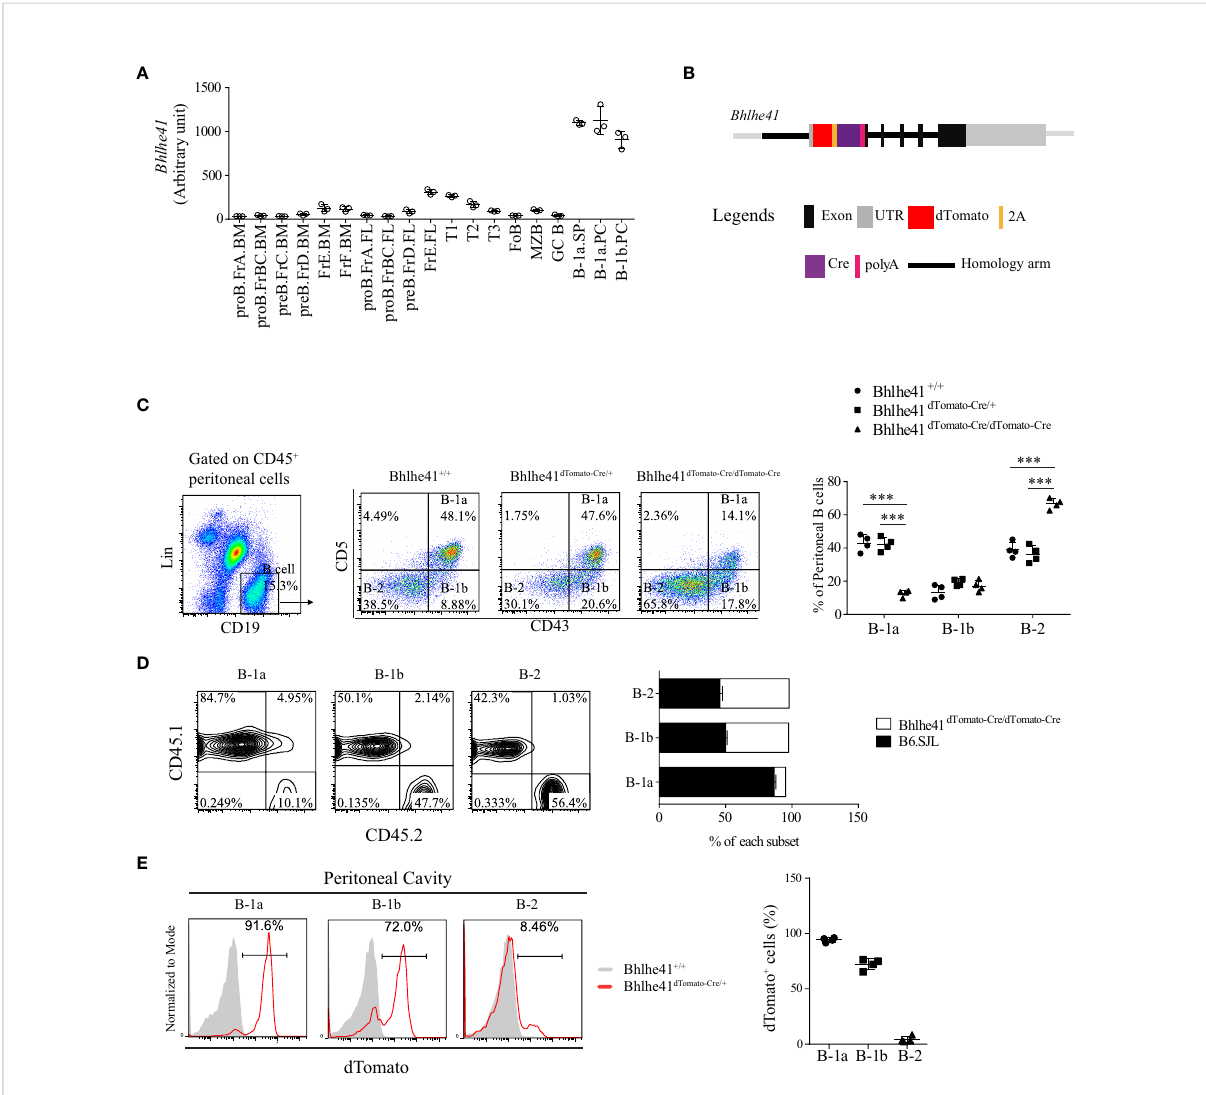
FIGURE 1 Generation of Bhlhe41 reporter and knockout mouse model Bhlhe41 dTomato-Cre . (A) Analysis of Bhlhe41 expression in different stages of B cells using a public gene expression microarray data (GSE15907) after quantile normalization. (B) Targeting construct for the Bhlhe41 locus with a dTomato-2A-Cre-polyA cassette inserted upstream of the Atg start site of Bhlhe41 locus. (C) Flow cytometric analysis of peritoneal B cells from adult Bhlhe41 +/+ , Bhlhe41 dTomato-Cre/+ , and Bhlhe41 dTomato-Cre/dTomato-Cre mice. The gating strategy for each type is illustrated on the left panel. One-way ANOVA followed by Bonferroni multiple comparison test was used for the statistical analysis. (D) Flow cytometric analysis of dTomato expression in peritoneal B cells from adult Bhlhe41 +/+ , Bhlhe41 dTomato-Cre/+ , and Bhlhe41 dTomato-Cre/dTomato-Cre mice. *** P < 0.001. (E) Flow cytometric analysis of dTomato in peritoneal B cells from adult Bhlhe41 +/+ and Bhlhe41 dTomato-Cre/+